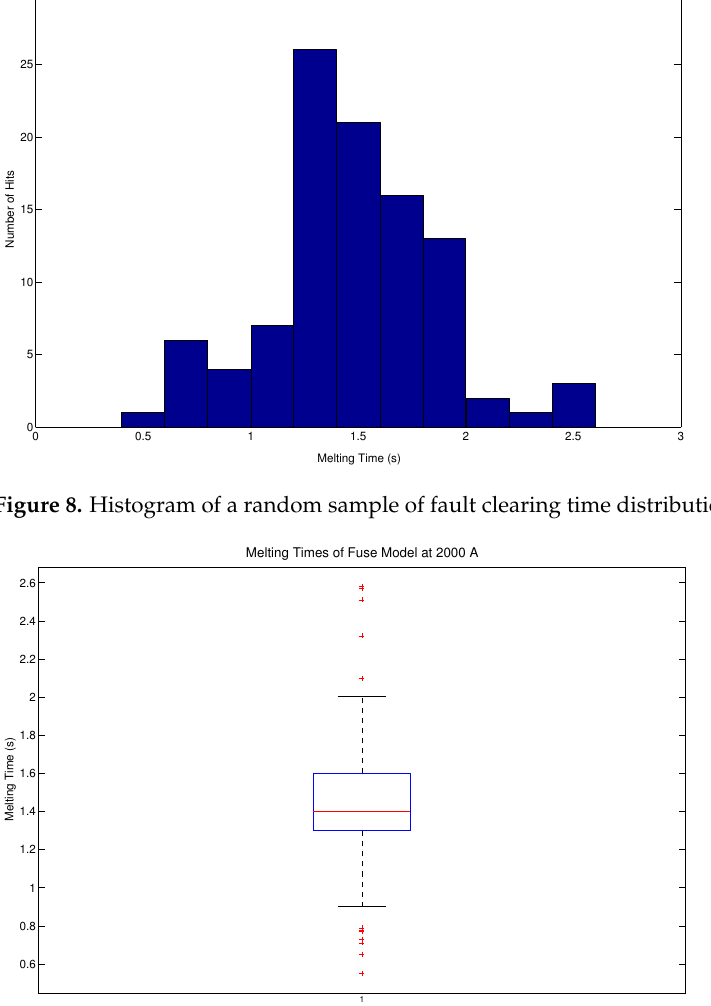
Figure 9. Boxplot of a random sample of fault clearing time distribution of 100